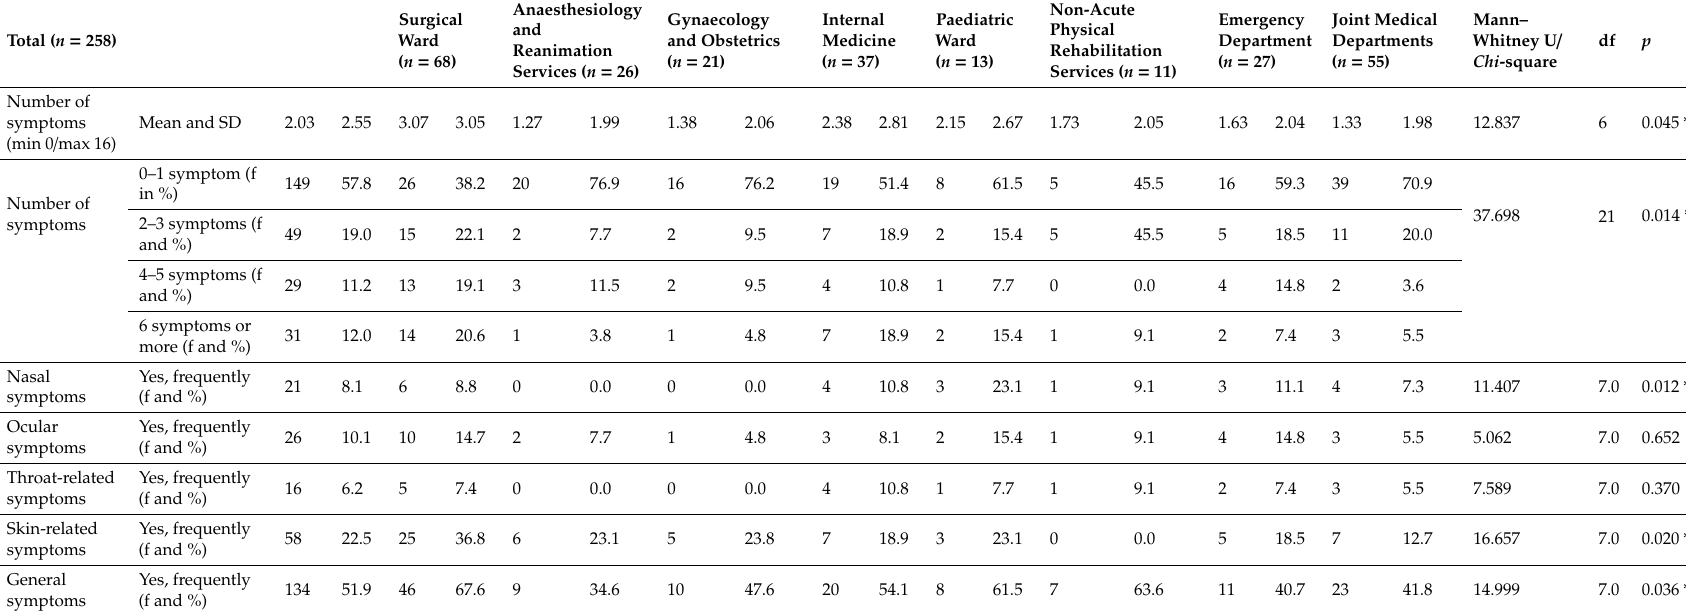
Table 2. Prevalence of self-perceived sick building syndrome (SBS) symptoms among healthcare